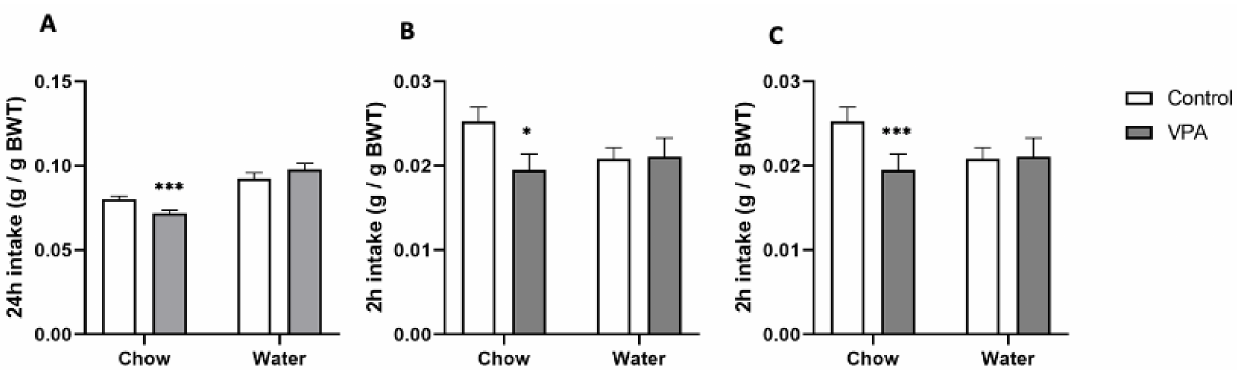
Figure 4. ( A ) 24-h chow intake of ad libitum -fed animals was significantly reduced in ASD rats. ( B ) Within 2 h of re-feeding after overnight chow deprivation, ASD animals exhibited significantly lower chow intake with no significant difference in water consumption. ( C ) Chow intake during 2 h of re-feeding after overnight chow and water deprivation was significantly reduced in VPA animals compared to healthy controls, while water intake was unaffected. Data are expressed as average intake ± SEM, n = 19/group. * p < 0.05, p < 0.01, *** p <